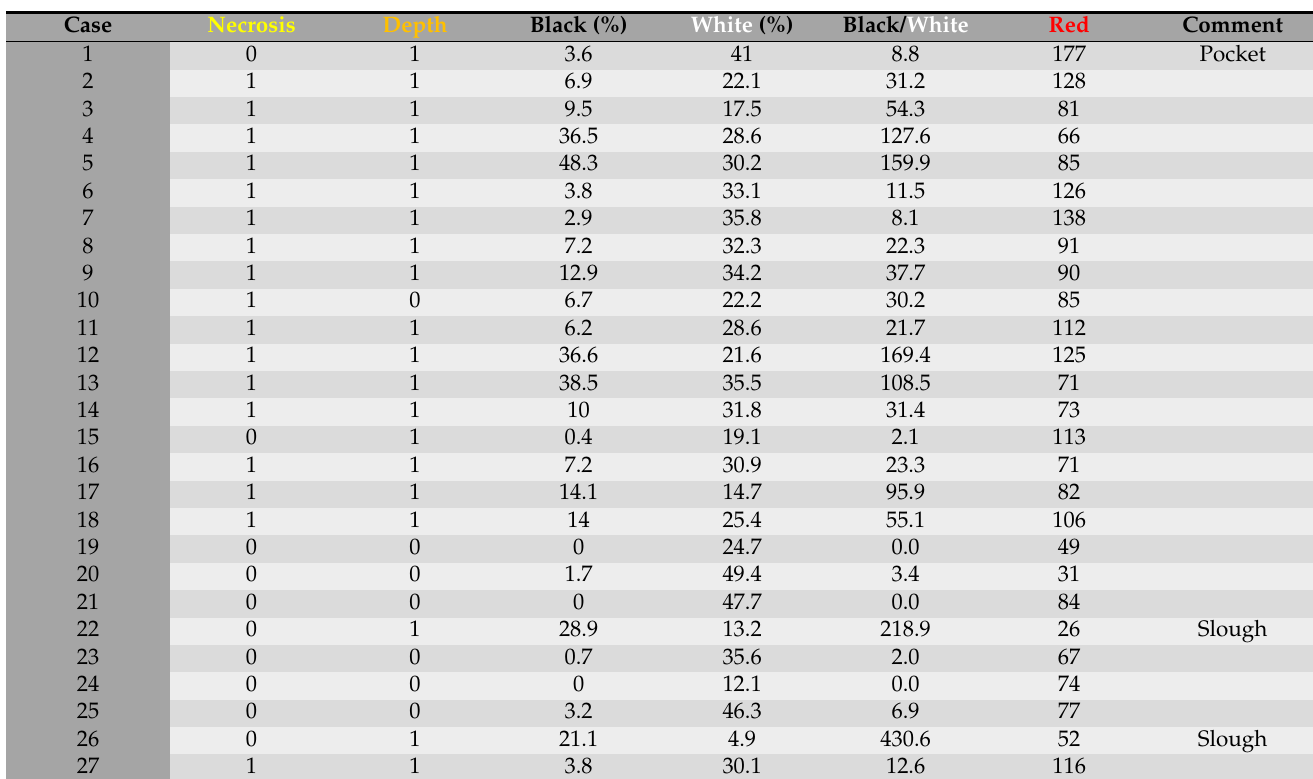
Table 1. Data of 27 cases with decubitus ulcers.